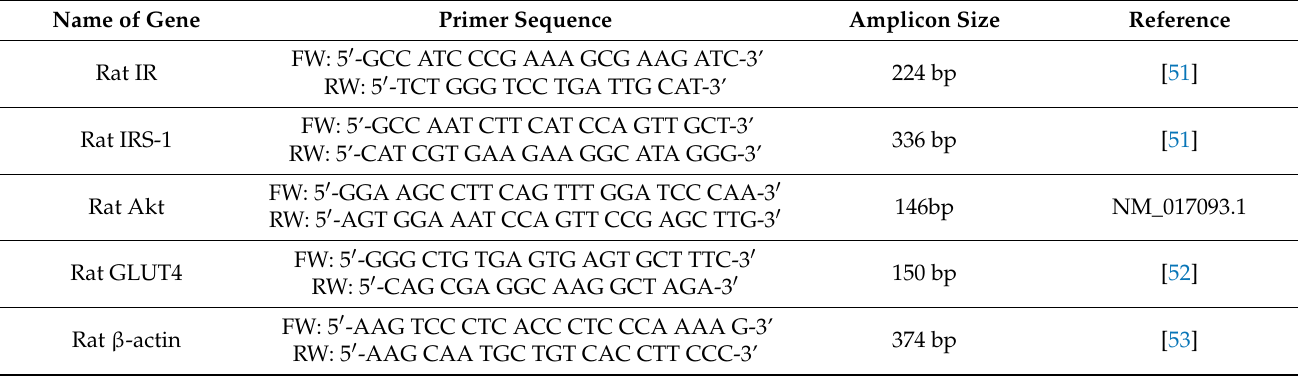
Table 2. Details of primer